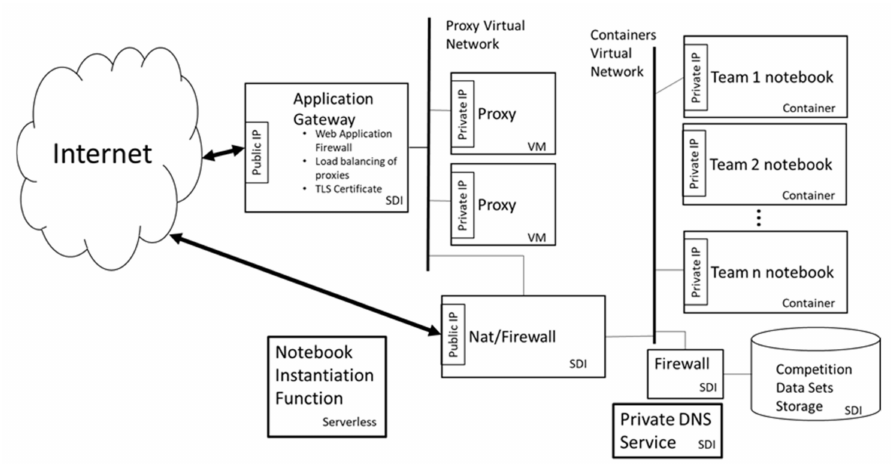
Figure 3. Architecture and component layout for a single